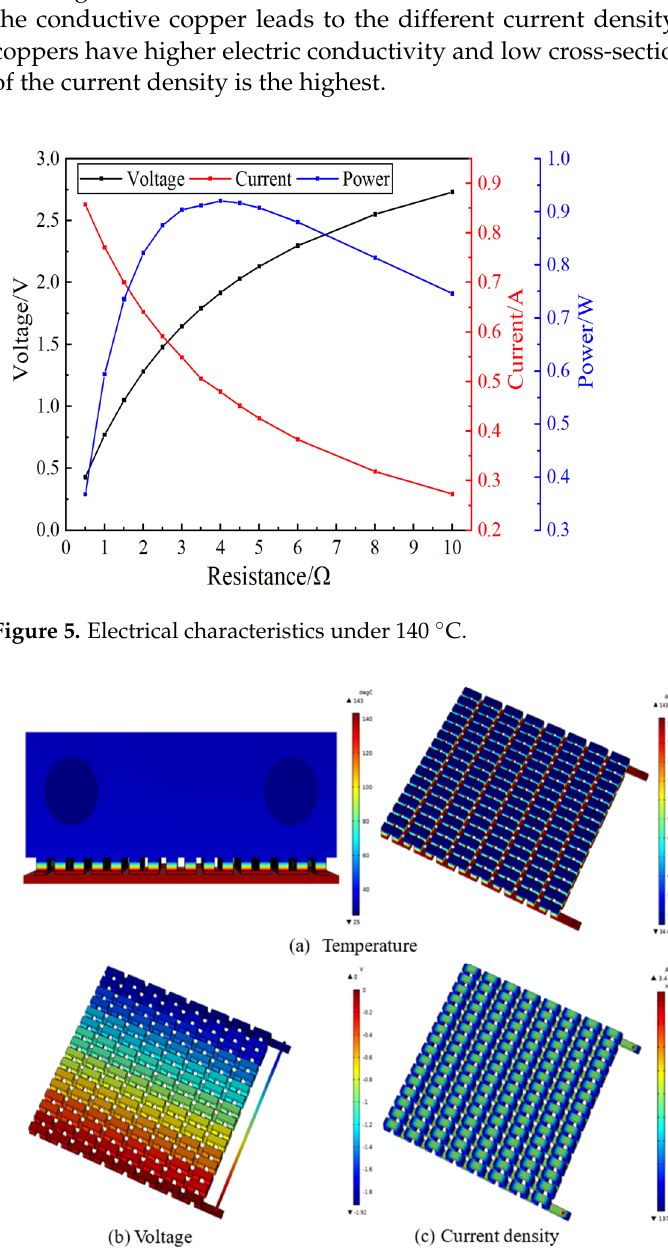
Table 1. Factors, control parameters, and the levels. Factor